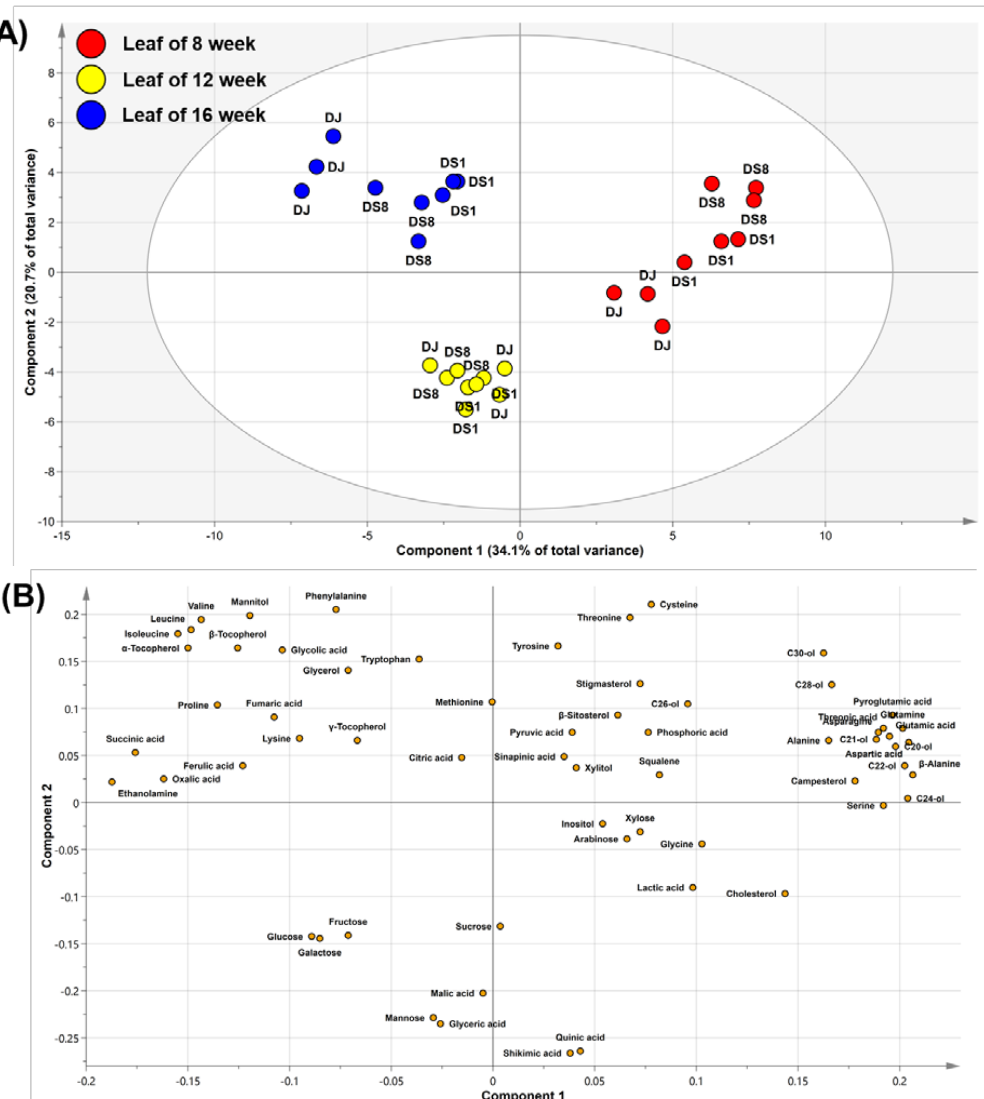
Figure 5. Score ( A ) and loading ( B ) plots of the PCA on rice leaves. Abbreviations: DJ, Oryza sativa L. cv. Dongjin; DS1, line 1 of transformed rice from DJ with PgDDS and CYP716A47 genes; DS8, line 8 of transformed rice from DJ with PgDDS and CYP716A47 genes; C20-ol, eicosanol; C21-ol, heneicosanol; C22-ol, docosanol; C24-ol, tetracosanol; C26-ol, hexacosanol; C28-ol, octacosanol; C30-ol, triacontanol.